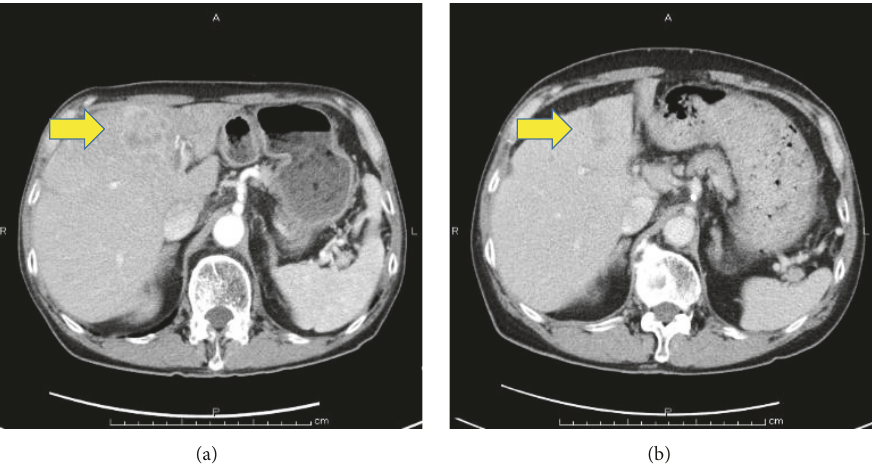
Figure 5: CT scans showed that the patient’s liver tumors (arrows) were reduced by the 78th (a) and 238th day (b) of admission after chemotherapy with CDDP and GEM.